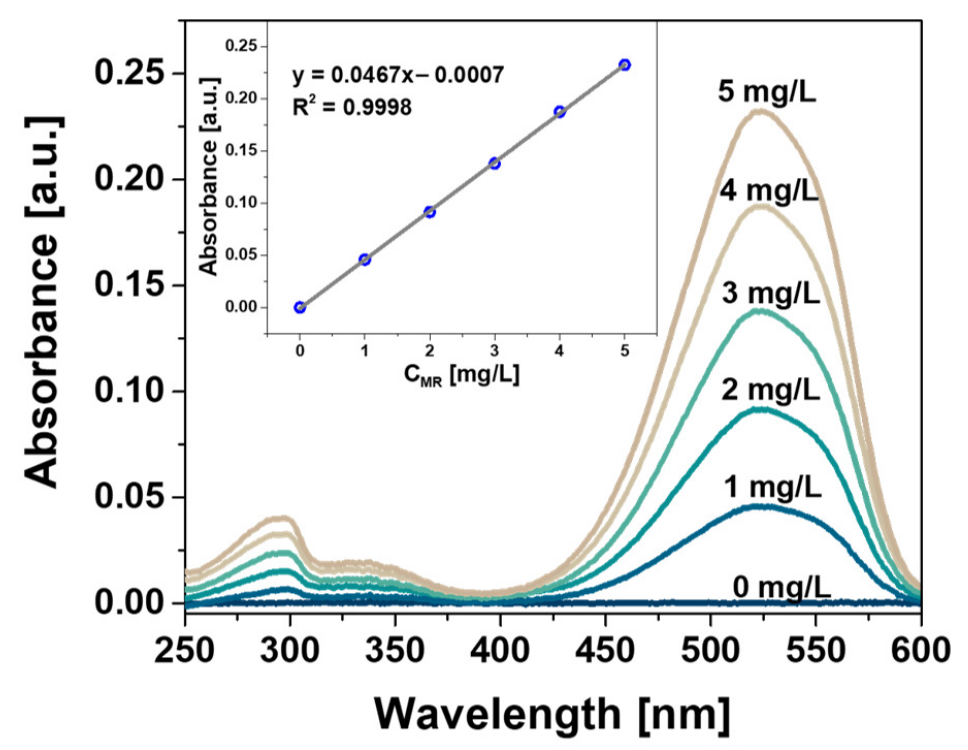
Figure 6. UV-Vis absorption spectra of standard aqueous MR solutions in a concentration range of 0–5 mg L − 1 . Inset: the corresponding calibration curve of MR measured at λ = 524